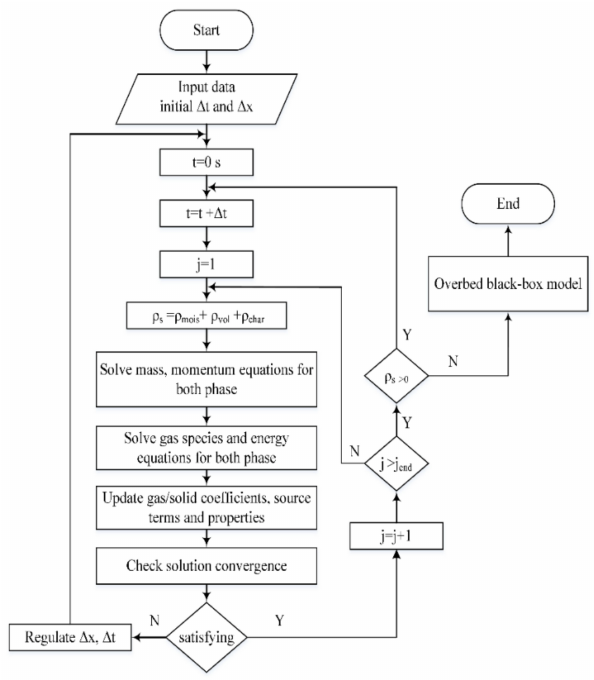
Figure 3. Solution algorithm for biomass combustor